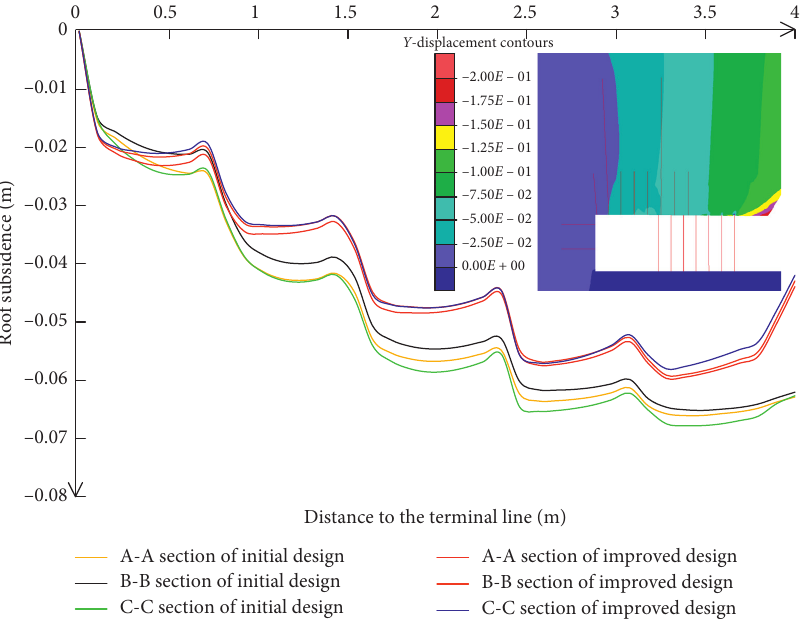
Figure 22: Roof subsidence curves of each section in the two support designs. Table 5: Technical parameters of the individual hydraulic props.